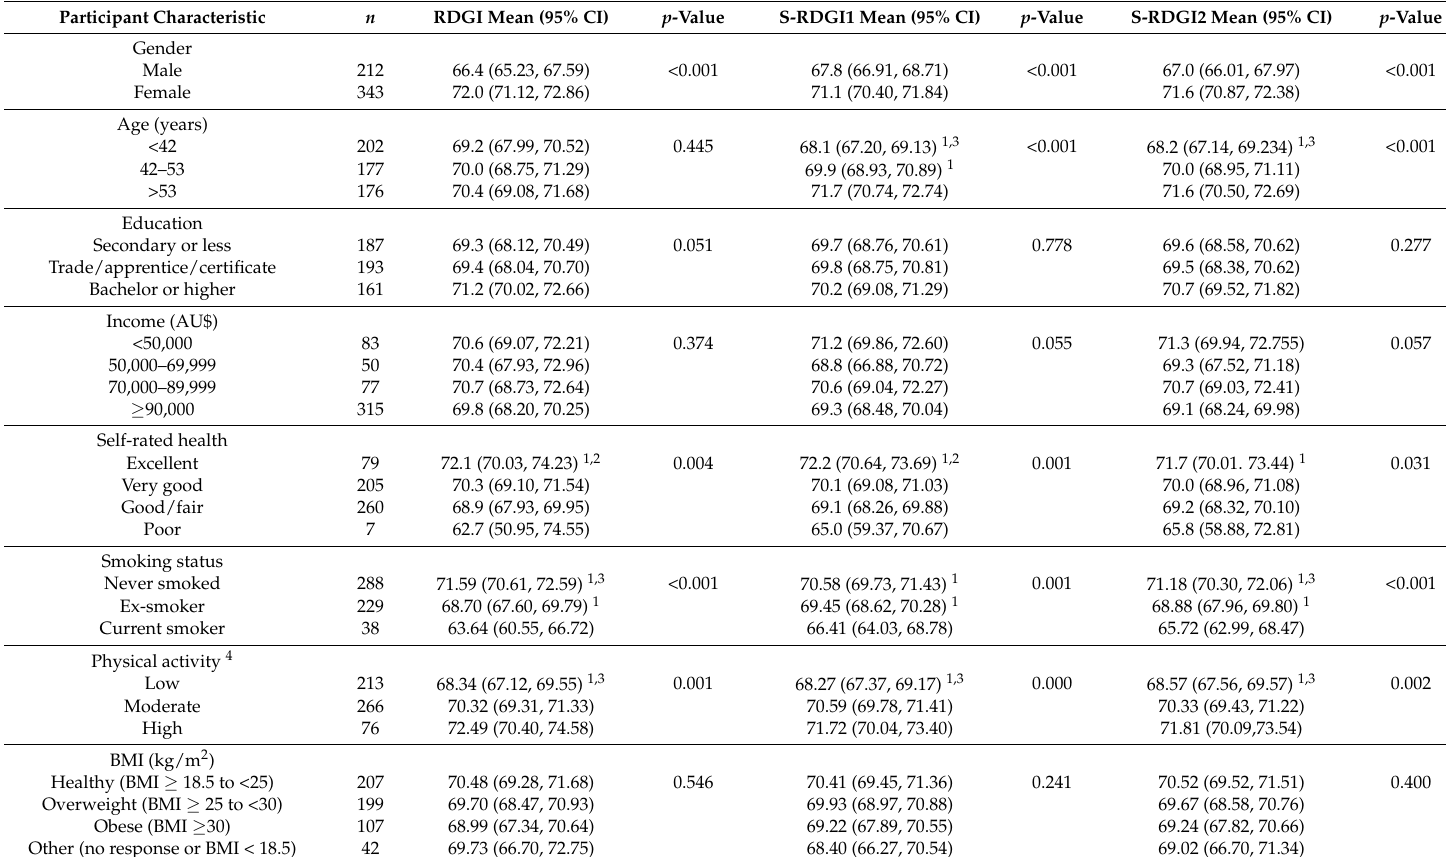
Table 5. Association between mean diet quality scores from the RDGI, S-RDGI1, and S-RDGI2 by selected participant